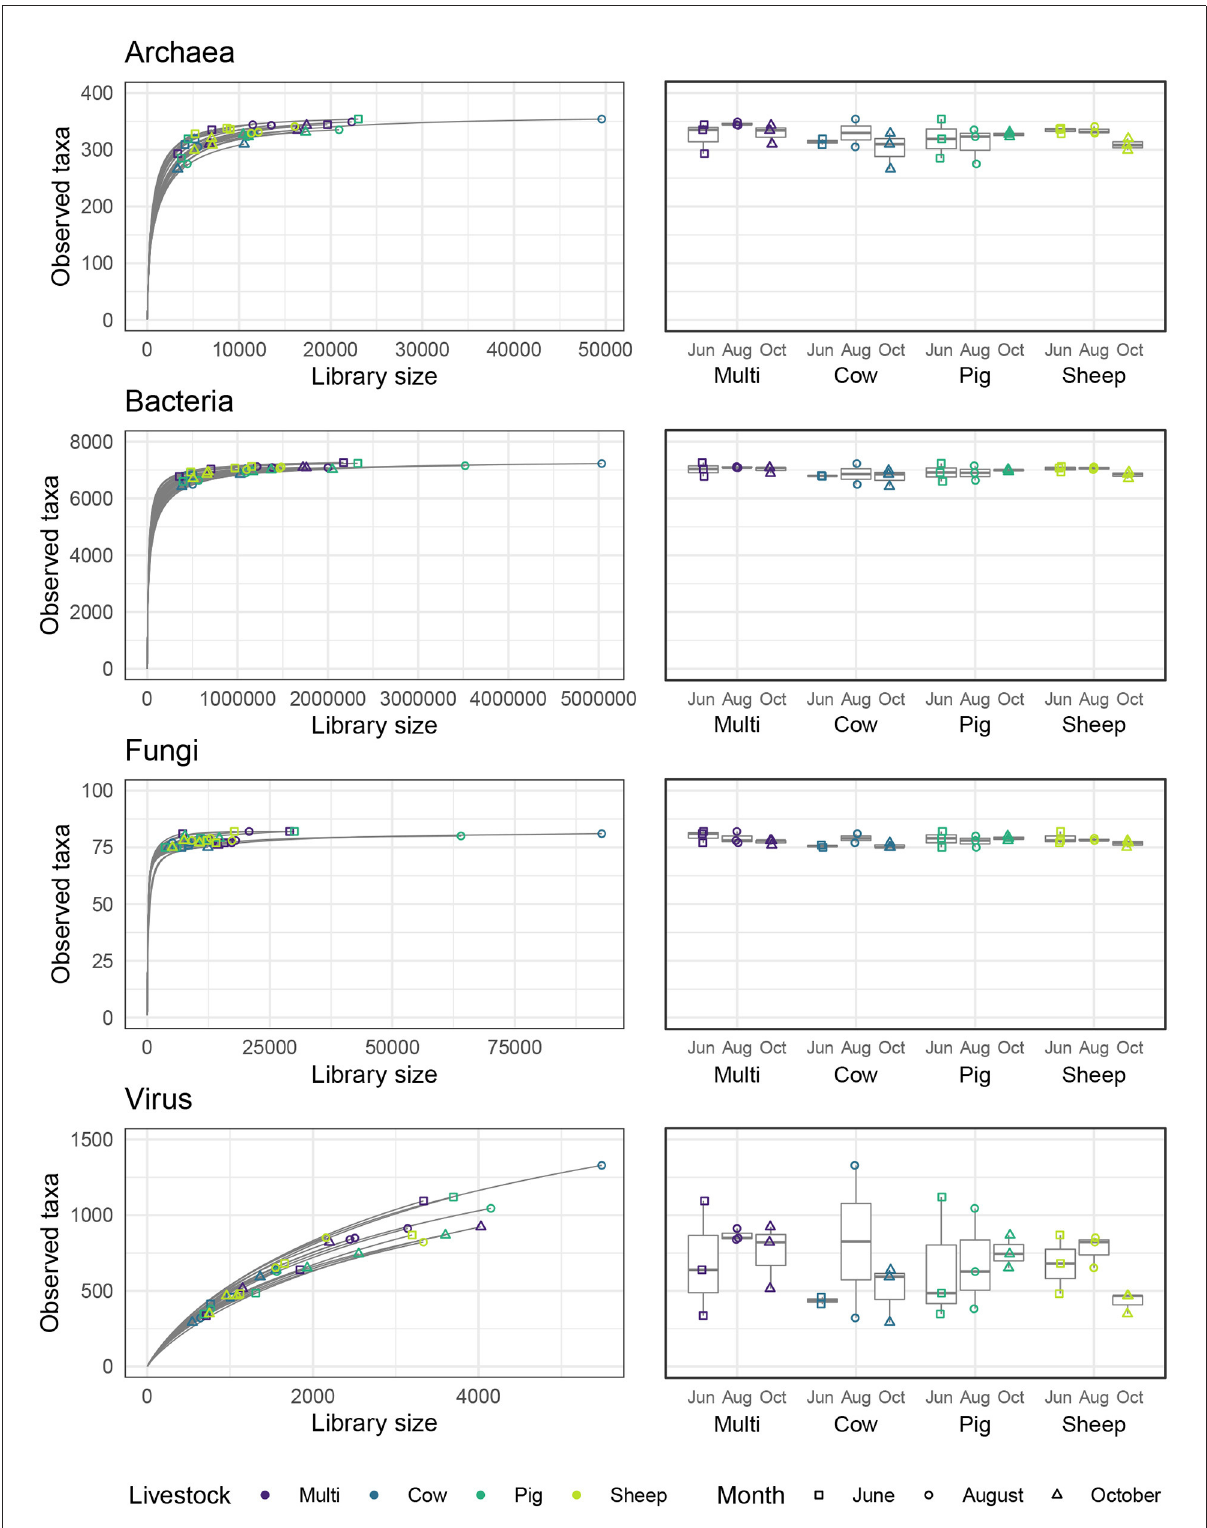
FIGURE3 Rarefaction curves for each microbial kingdom and numbers of observed taxa across livestock grazing treatments and